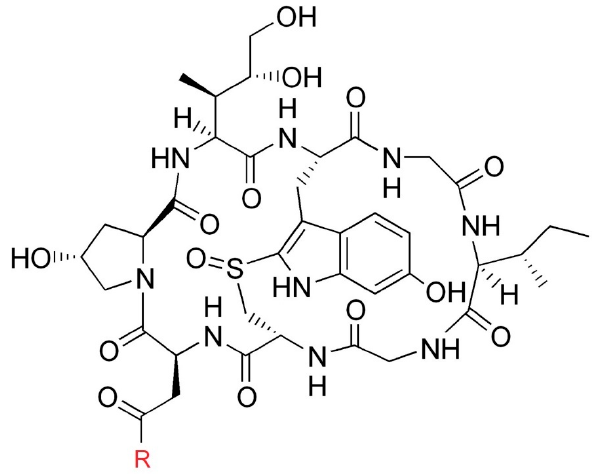
Figure 3. Structure of amatoxins. R = NH 2 for α -amanitin, R= OH for β -amanitin.